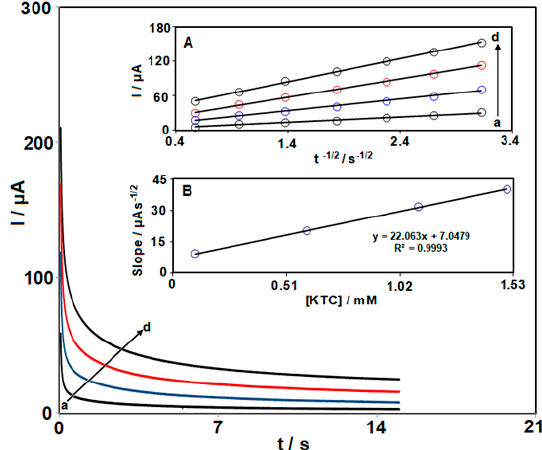
Figure 8. Chronoamperometric behavior of Ce-BTC MOF/IL/CPE in PBS (0.1 M; pH = 7.0) at a potential of 300 mV for variable KTC contents (a–d: 0.1, 0.6, 1.1, and 1.5 mM). Insets: ( A ) plots of I vs. t − 1/2 ; ( B ) plots of the slopes from the straight lines vs. KTC